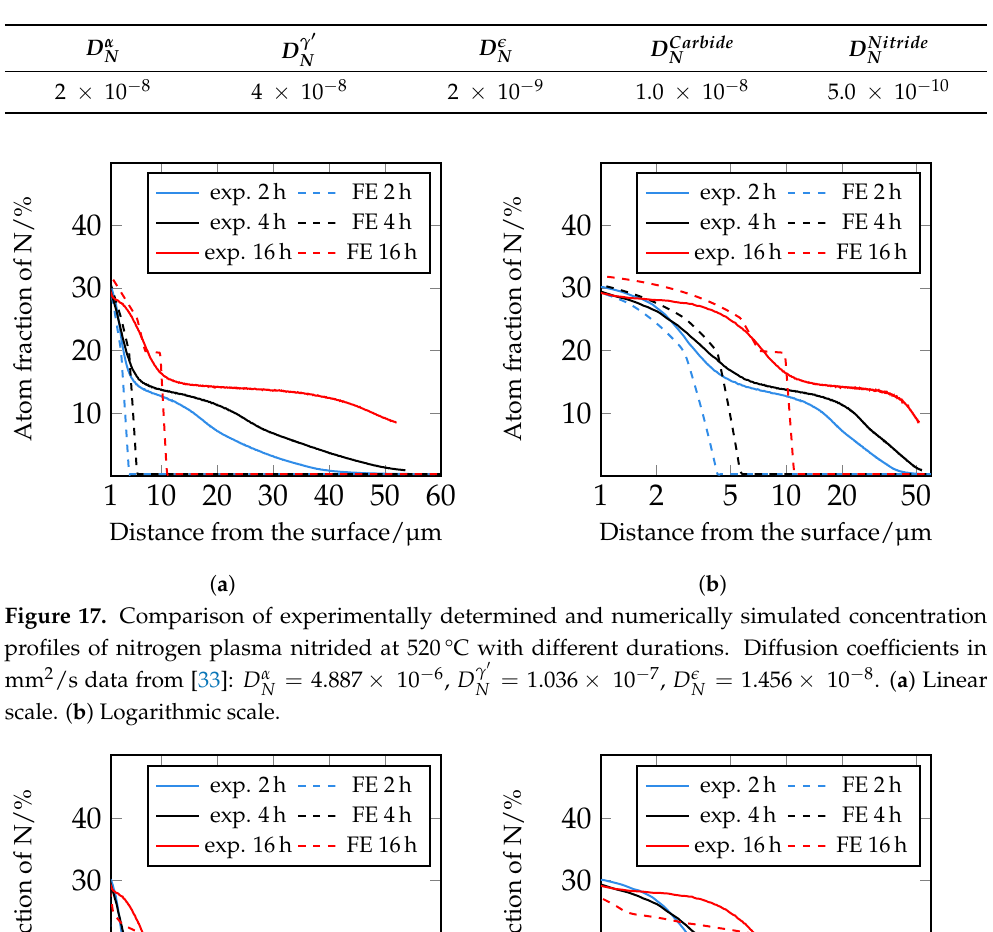
Table 7. Iteratively adjusted diffusion coefficients in mm 2 /s of N in iron nitrides and the α -Fe phase for 520°C.